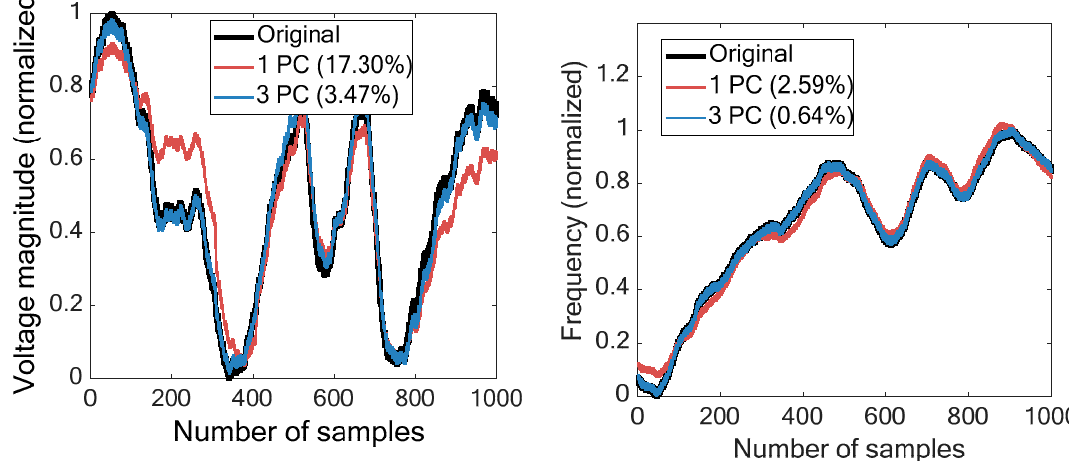
Figure 12. Original vs. reconstructed voltage magnitudes ( left ) and frequencies ( right ) after the spatiotemporal data compression.